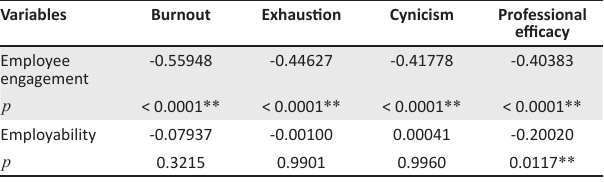
TABLE 4: Correlations between subscales of burnout, employee engagement and self-perceived employability: Pearson product-moment correlation coefficients, N = 158, Prob > | r | under H0: Rho = 0.